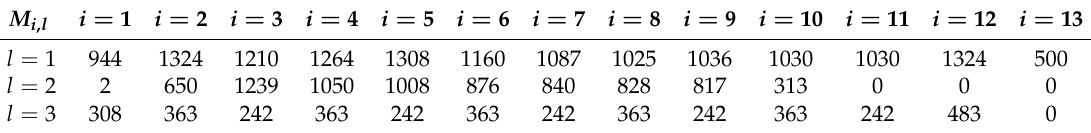
Table A1. Number of assemblies of the fuel l ∈ L belonging to the removal i ∈ I M i , l . M i , l